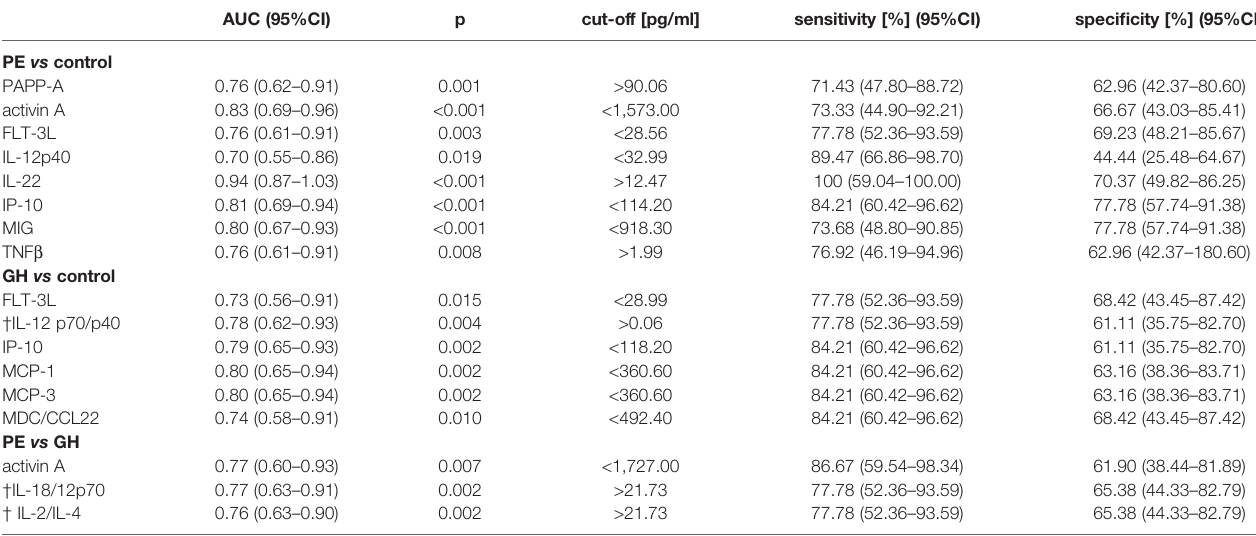
TABLE 3 | Area under curve (AUC) for selected